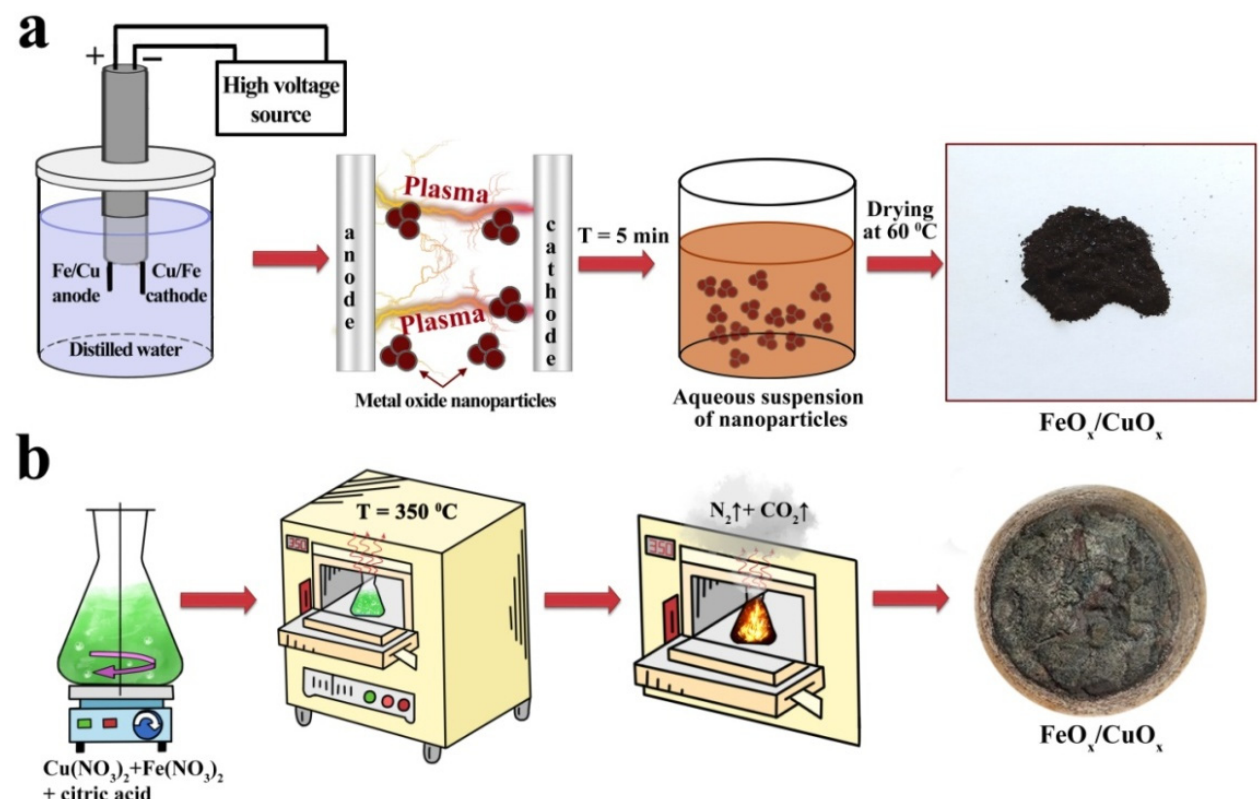
Figure 1. Scheme for the synthesis of metal oxides by the underwater plasma ( a ) method and the combustion method ( b ).